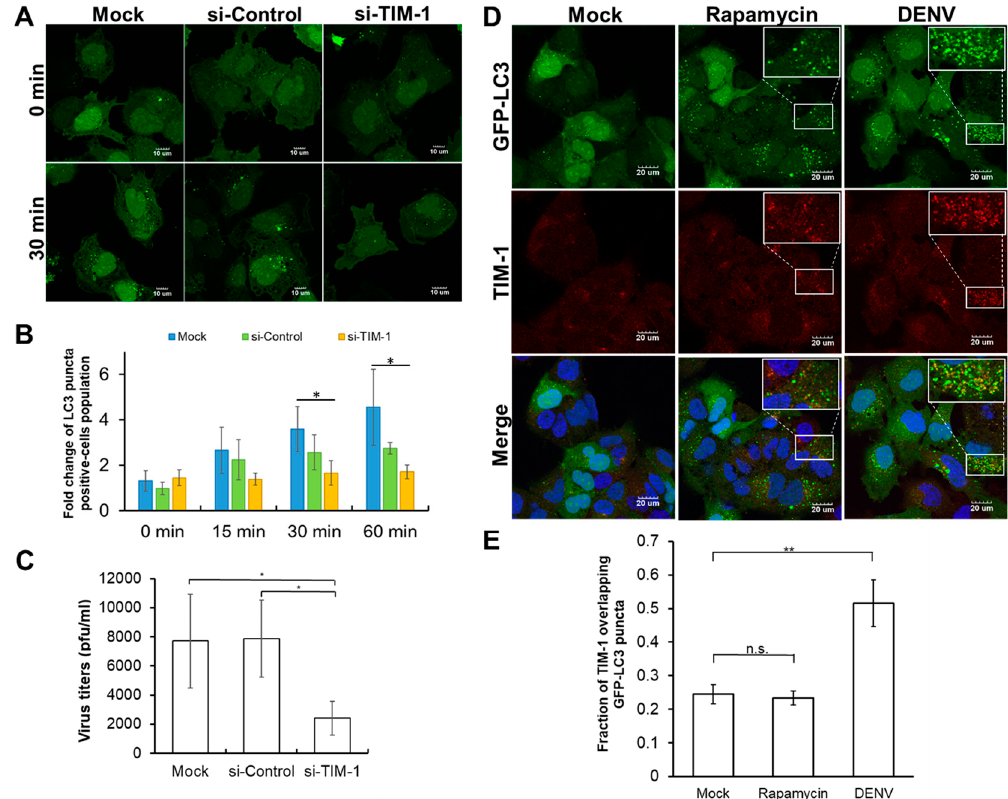
Figure 2. The requirement of TIM-1 for Dengue virus (DENV)-induced autophagy and virus production. ( A ) The formation of autophagosomes (green) in GFP-LC3-Huh7.5 cells treated either with si-control or si-TIM-1 prior to DENV infection at a multiplicity of infection (MOI) of five were visualized by Olympus FluoView 1000 confocal microscopy at 0 and 30 min post-infection, respectively. The scale bar represents 10 µ m. ( B ) The e ff ects of either si-control (red) or si-TIM-1 (yellow) treatment on the formation of autophagy in GFP-LC3-Huh7.5 cells were determined by the percentage of autophagy-positive cells. siRNA-free group indicates as mock (blue). The error bars represent standard deviations from three independent experiments ( > 200 cells). * p < 0.05. ( C ) The e ff ects of TIM-1 on DENV production were examined. GFP-LC3-Huh7.5 cells were treated with siRNA prior to DENV infection. The titers of the extracellular virus were measured by a plaque assay 24 h post-infection. The means of three independent experiments performed in triplicate are shown. * p < 0.05. ( D ) Distribution of TIM-1 (red) and GFP-LC3 punta (green) in GFP-LC3-Huh7.5 cells treated either with rapamycin or DENV infection for an hour were determined by confocal microscopy (Olympus FV-10i). The insets showed more colocalization of TIM-1 with LC3 puncta in DENV-infected cells rather than in rapamycin-treated cells. Scale bar, 20 µ m. ( E ) The colocalization of TIM-1 with GFP-LC3 punta was quantitatively analyzed by Mander’s coe ffi cient from three independent experiments ( > 25 cells). n.s. means non-significant; ** p <